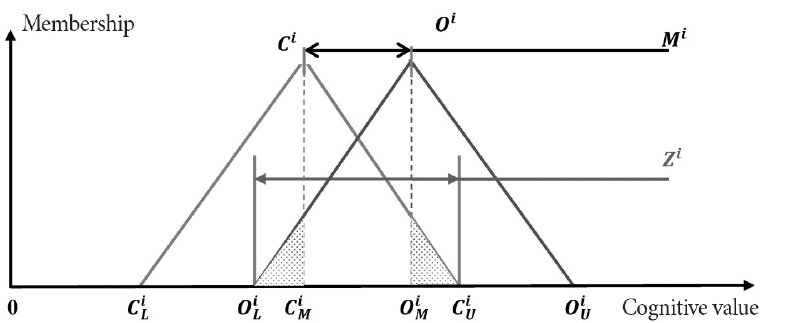
Figure 1. Schematic diagram of the FDM